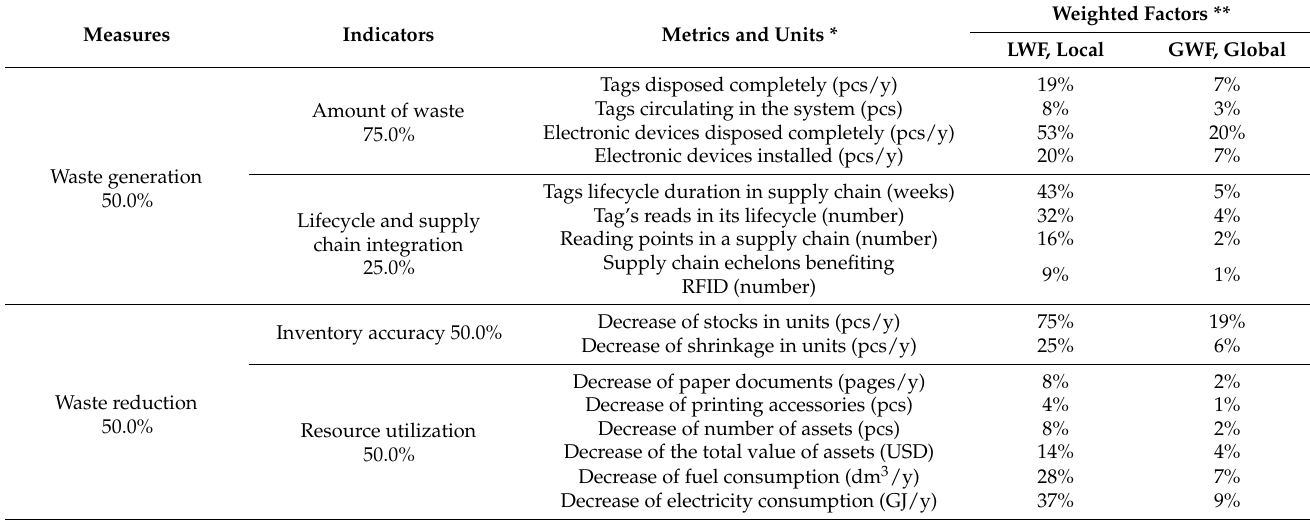
Table 3. Normalization of the evaluation of environmental indicators using the AHP